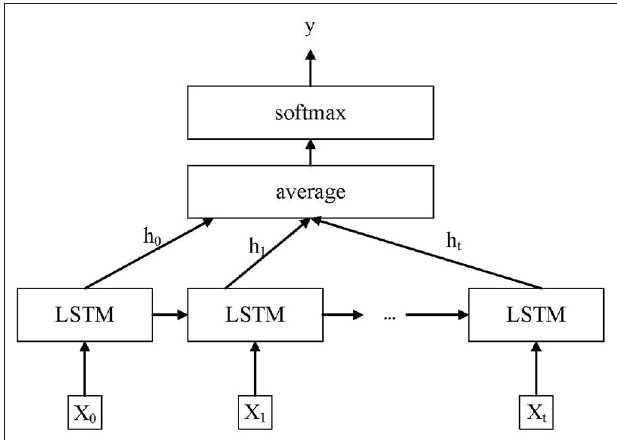
FIGURE 5 | Long short-term memory classification